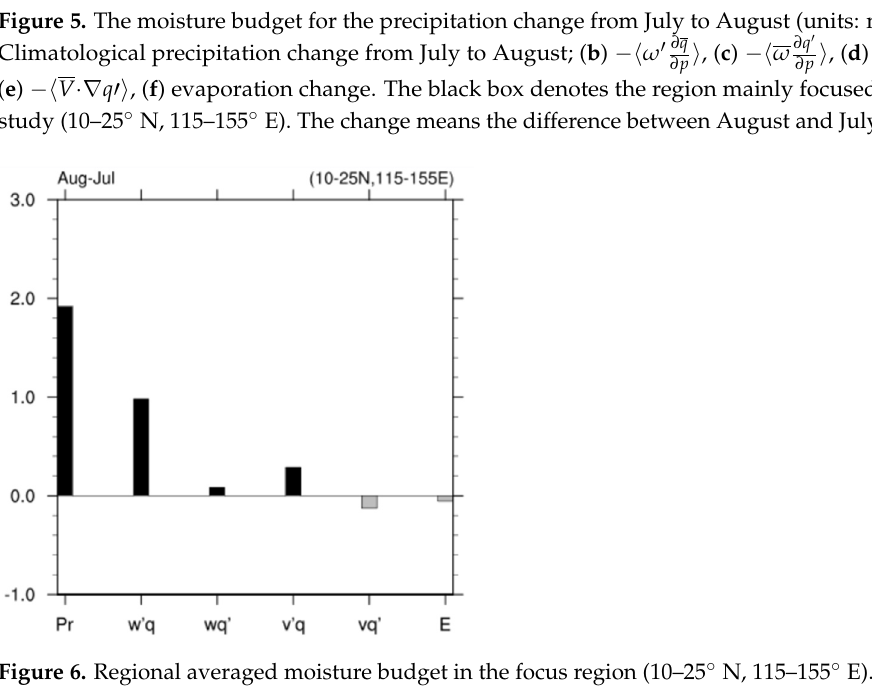
Figure 6. Regional averaged moisture budget in the focus region (10–25° N, 115–155° E).